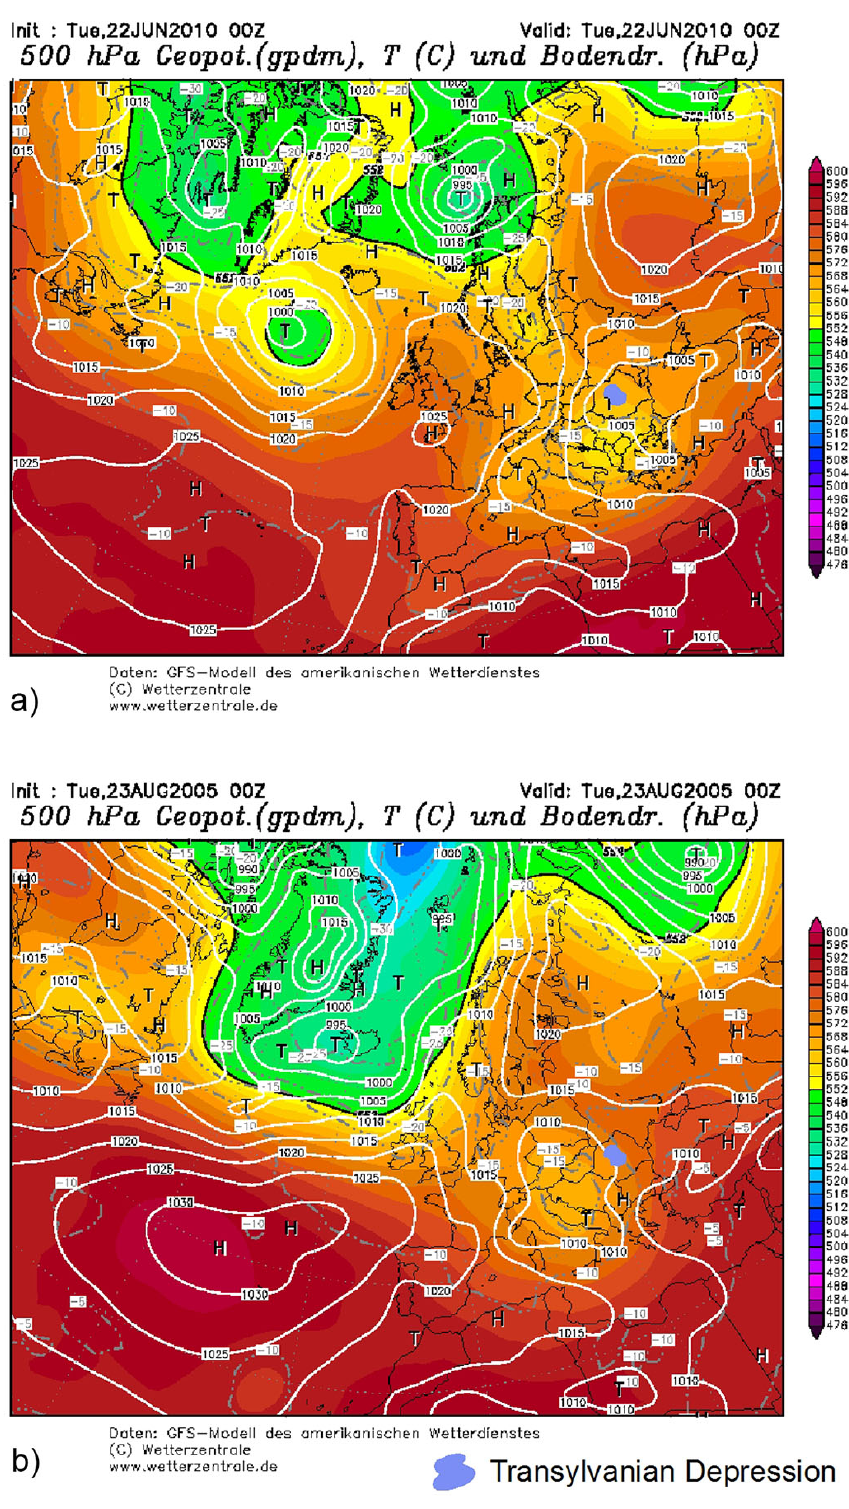
Fig. 2. Sea level pressure (hPa), 500hPa geopotential height (gpdm) and temperature ( ◦ C) in the Feernic 2005 (a) and Ciunga 2010 (b) flash-flood events (http://www.wetterzentrale.de/topkarten/fsavneur.html).